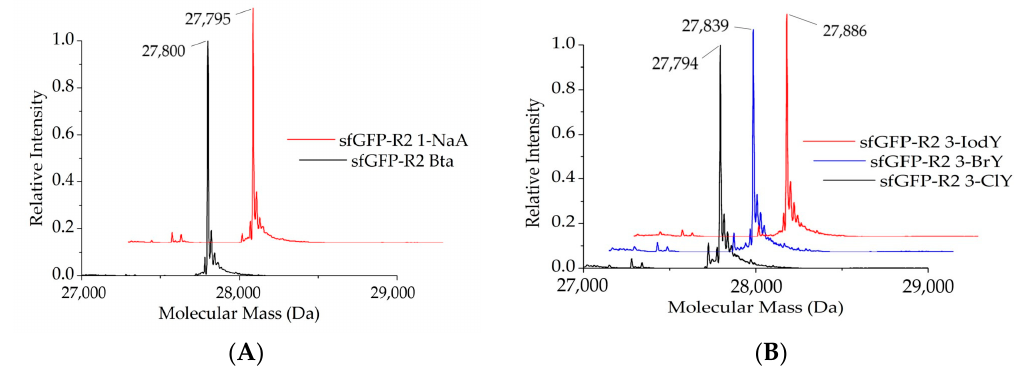
Figure 4. Deconvoluted ESI-MS profiles of the sfGFP–R2TAG reporter, revealing successful protein labelling with Trp and Tyr analogs. ( A ) Full-length sfGFP–R2_Bta and sfGFP–R2_1-NaA were produced by co-expression of Mm PylRS–SMG. The calculated molecular mass of sfGFP–R2_Bta is 27,800.31 Da, whereas the observed mass is 27,801 Da. The calculated molecular mass of sfGFP–R2_1-NaA is 27,794.3 Da whereas the observed mass is 27,794 Da. ( B ) Full-length sfGFP–R2_3-ClY, sfGFP–R2_3-BrY, and sfGFP–R2_3-IodY were produced by co-expression of Mm PylRS–GML. The calculated molecular mass of sfGFP–R2_3-ClY is 27,794.07 Da, whereas the observed mass is 27,795 Da. The calculated molecular mass of sfGFP–R2_3-BrY is 27,838.02 Da, whereas the observed mass is 27,839 Da. The calculated molecular mass of sfGFP–R2_3-IodY is 27,886 Da, whereas the observed mass is 27,886 Da.